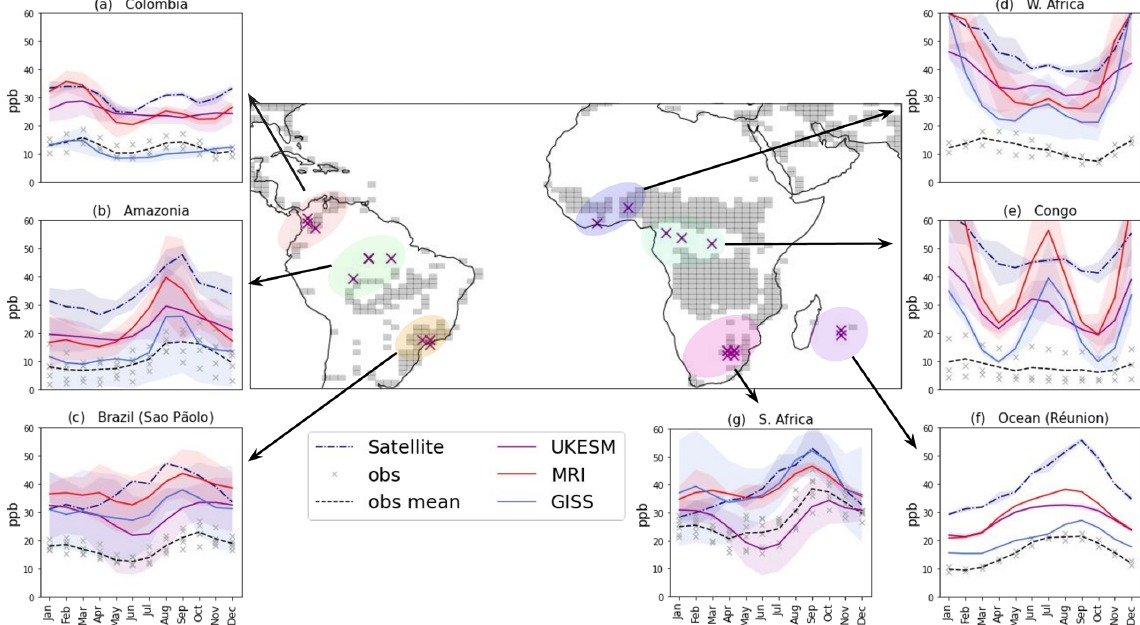
Figure 1. Panels (a–g) compare monthly mean O 3 (black dashed line) from site measurements averaged over seven regions to model predictions for the period 1990–2014 and satellite products from the TES satellite at 825hPa (navy dash–dot line). Model means are shown for UKESM1 (purple solid line), GISS (blue solid line) and MRI (red solid line), and 2 standard deviations from the mean are shaded. Grey crosses indicate monthly mean O 3 measurements from individual sites and years. The central panel marks the locations where O 3 measurement sites are located (purple crosses) and how the sites have been grouped (coloured shading). Observations (a–c) and (f and g) use data from the Tropospheric O 3 Assessment Report (TOAR I; Schröder, 2021; Schultz et al., 2017), (d and e) from INDAAF data (2021) (http://indaaf.obs-mip.fr, last access: 9 October 2021) and (e) from CONGOFLUX in Yangambi, DR Congo. Grey grid cells cover areas where NO x emissions are above the 95th percentile for the region 40 ◦ S–40 ◦ N in 2100 (prescribed by Rao et al., 2017; Riahi et al., 2017), indicative of biomass burning areas and cities. Unshaded areas are referred to as “remote”